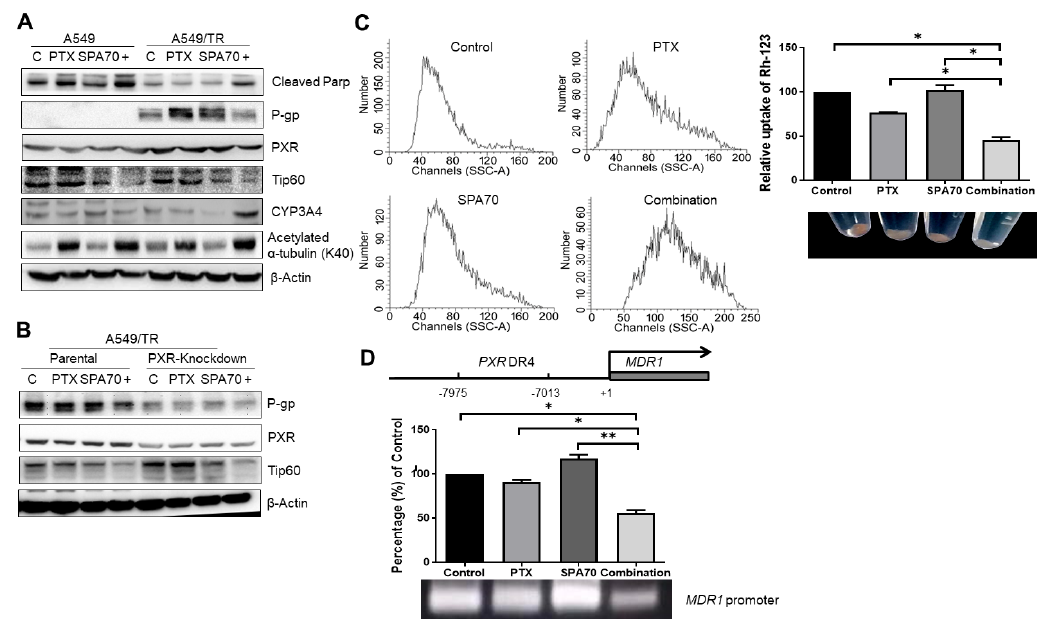
Figure 2. Combination regimen of PTX and SPA70 inhibits P-gp expression in PTX-resistant A549 cells. All the experiments were conducted with 2 nM PTX, 10 μM SPA70, or combined usage for 48 h ( n = 3). ( A ) Validation of PTX-resistant A549 cells, indicated as P-gp expression, and signaling pathway analysis in both A549 and A549/TR cells upon corresponding treatment. “+” indicates combination treatment of PTX and SPA70. Protein expression was quantified by blot density as shown in Supplemental Figure 2A. ( B ) PXR knockdown decreased P-gp expression whereas it increased Tip60 protein expression. “+” indicates combination treatment of PTX and SPA70. Protein expressions was quantified by blot density as shown in Supplemental Figure 2B. ( C ) Rhodamine-123 is a P-gp substrate and indicator for MDR1 transporter activity. FACS analysis was carried out in A549/PTX cells and lower accumulation of Rh-123 resulting from repressed P-gp was observed in the combination treatment group. Rh-123-stained cells were quantified by Modfit LT software and shown as a bar graph on the right. ( D ) ChIP assay was performed to investigate whether combination treatment disassociated PXR from MDR1 promoter. *, p < 0.05; **, p < 0.01, compared with indicated groups.